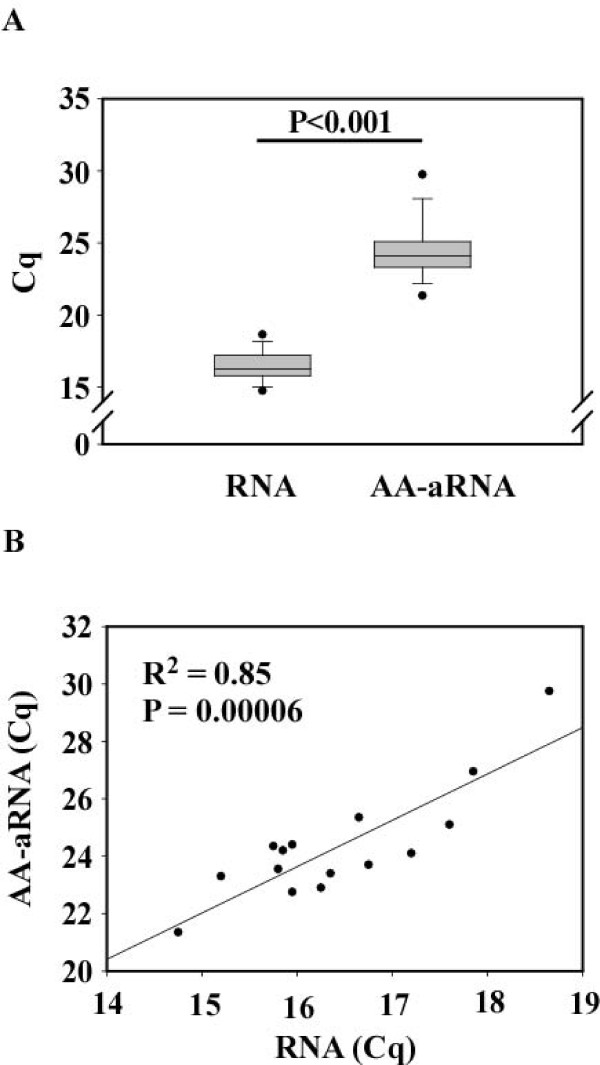
Amplification and amino allyl labeling inhibit qPCR. Total RNA extracted from whole blood cells of 15 healthy brain-dead organ donors was subjected to amplification by T7 polymerase and amino allyl labeling to generate AA-aRNA. 1 μg of un-amplified and un-labeled RNA and 100 ng AA-aRNA (amplified and amino allyl labeled RNA but not coupled with fluorescent dye) were reverse transcribed using SuperScript II, resulting cDNAs were diluted 10-fold and subjected to qPCR using primers specific for ACTB. (A) Cq obtained from the 15 samples are represented in a box plot. A statistically significant difference was detected between RNA and AA-aRNA (t = -25.23; P < 0.001; paired t-test). (B) Cq obtained with RNA and AA-aRNA for each of the 15 patients were strongly correlated (R2 = 0.85; P = 0.00006; Pearson product moment correlation). Similar results were obtained in two independent experiments.